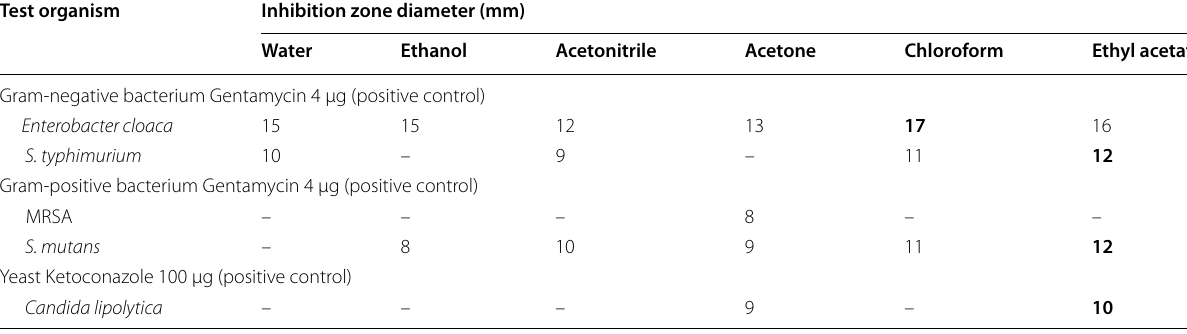
Table 4 Evaluation of the antagonistic effect of the different mushroom extracts against the indicator microorganisms Test